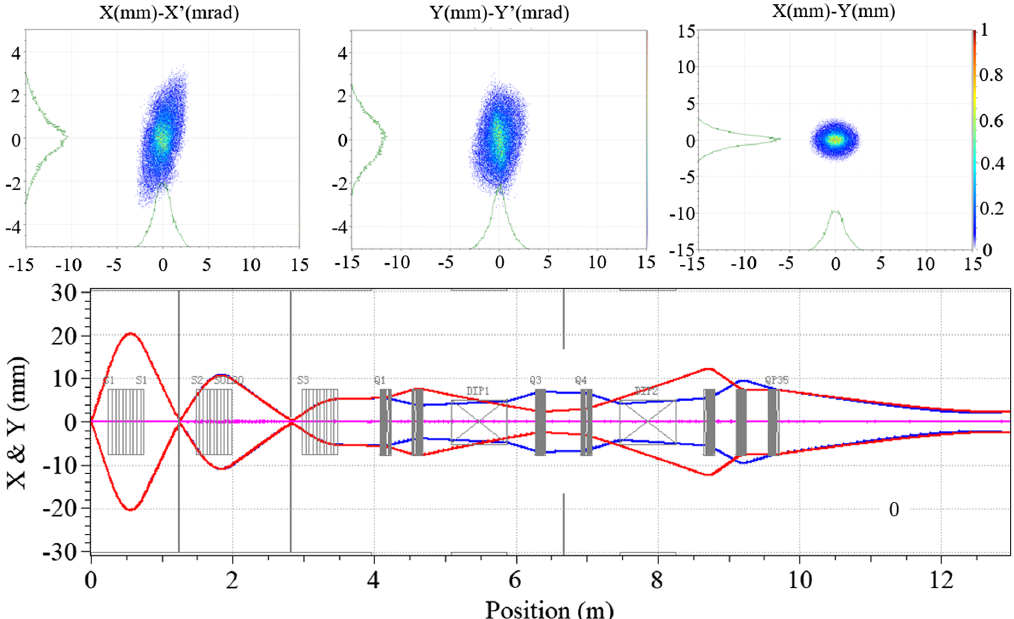
FIG. 5. Upper: simulation results for the transverse phase space at the exit of the horizontal beamline. Plots from left to right are the phase space diagrams in the x and y directions, and a cross-section of the beam at the irradiation point. Lower: beam envelope evolution along the z axis. The blue line represents the x -direction, and the red line represents the y